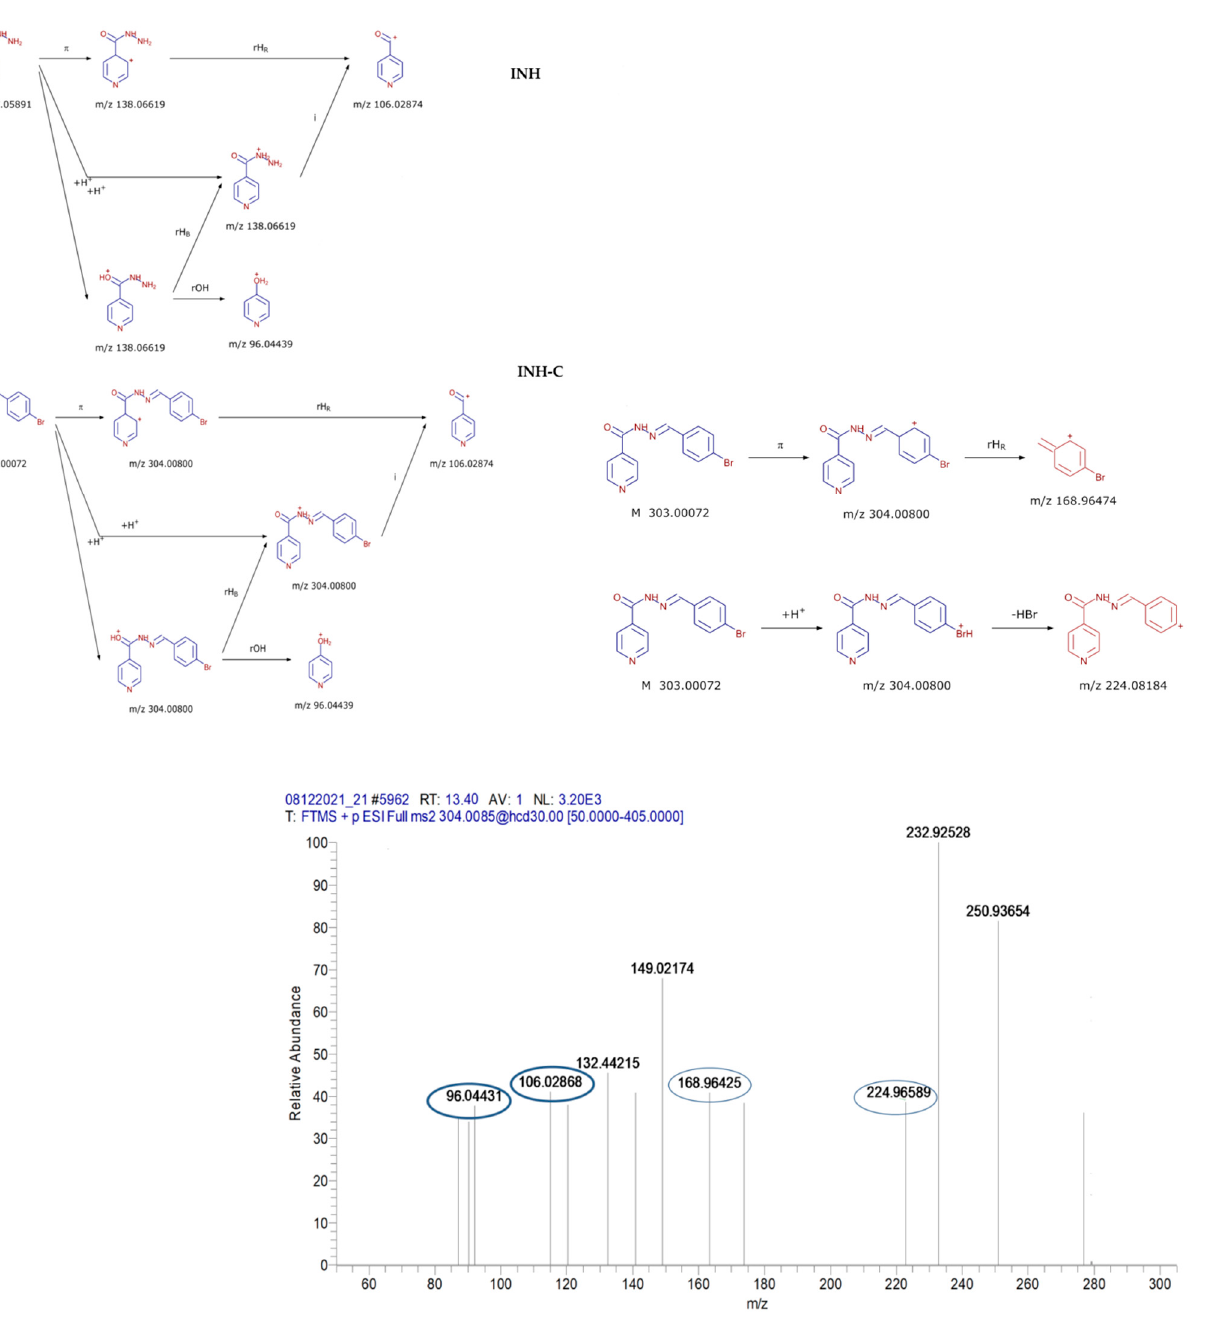
Figure 2. Common fragmentation pathways of INH-c and the parent compound INH and the characteristic fragments of the derivative compound identified in the MS 2 spectra.